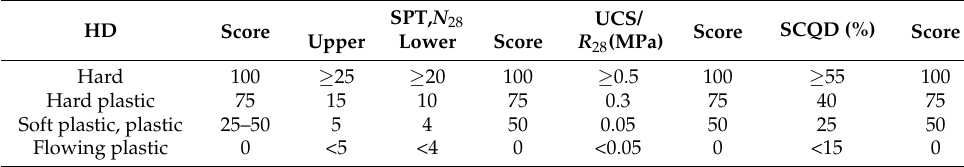
Table 6. The scoring rules of each